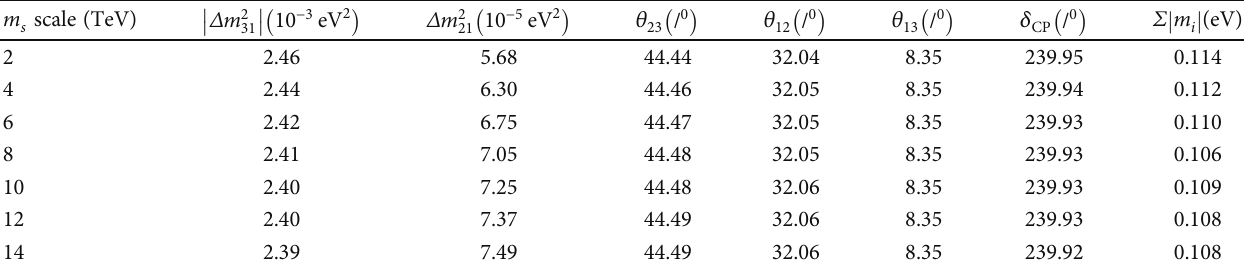
for IH case ( tan β = 40 , M s